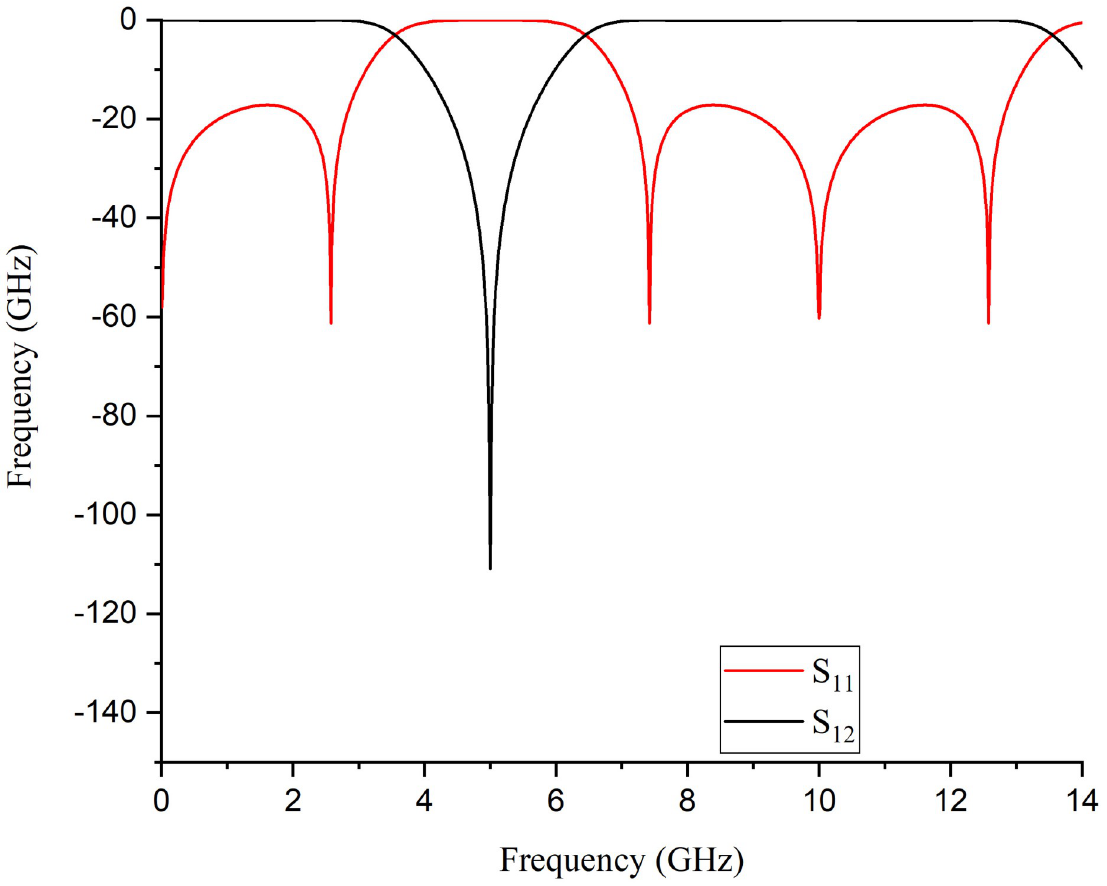
Fig 4. Simulated results of the ideal transmission line